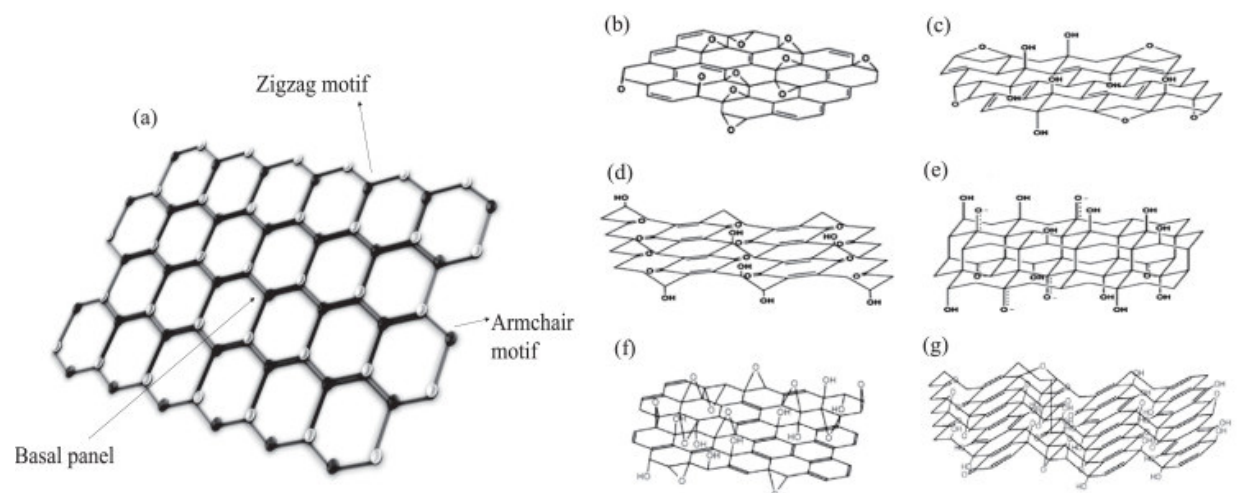
Figure 1. Structures of pristine graphene ( a ) and its GO derivatives based on Hofmann ( b ), Ruess ( c ), Scholz–Boehm ( d ), Nakajima–Matsuo ( e ), Lerf–Klinowski ( f ), and Szabo ( g ) models. Reproduced, adapted, and reprinted with permission from Ref. [48] under CC license.